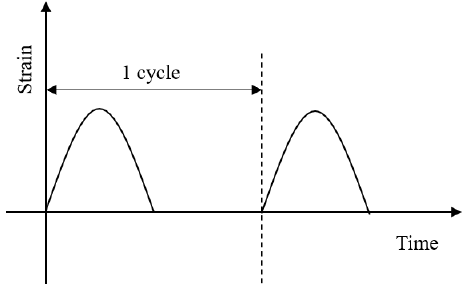
Figure 4. Waveform type for tests. Table 1. Strain of rubber components for tests.